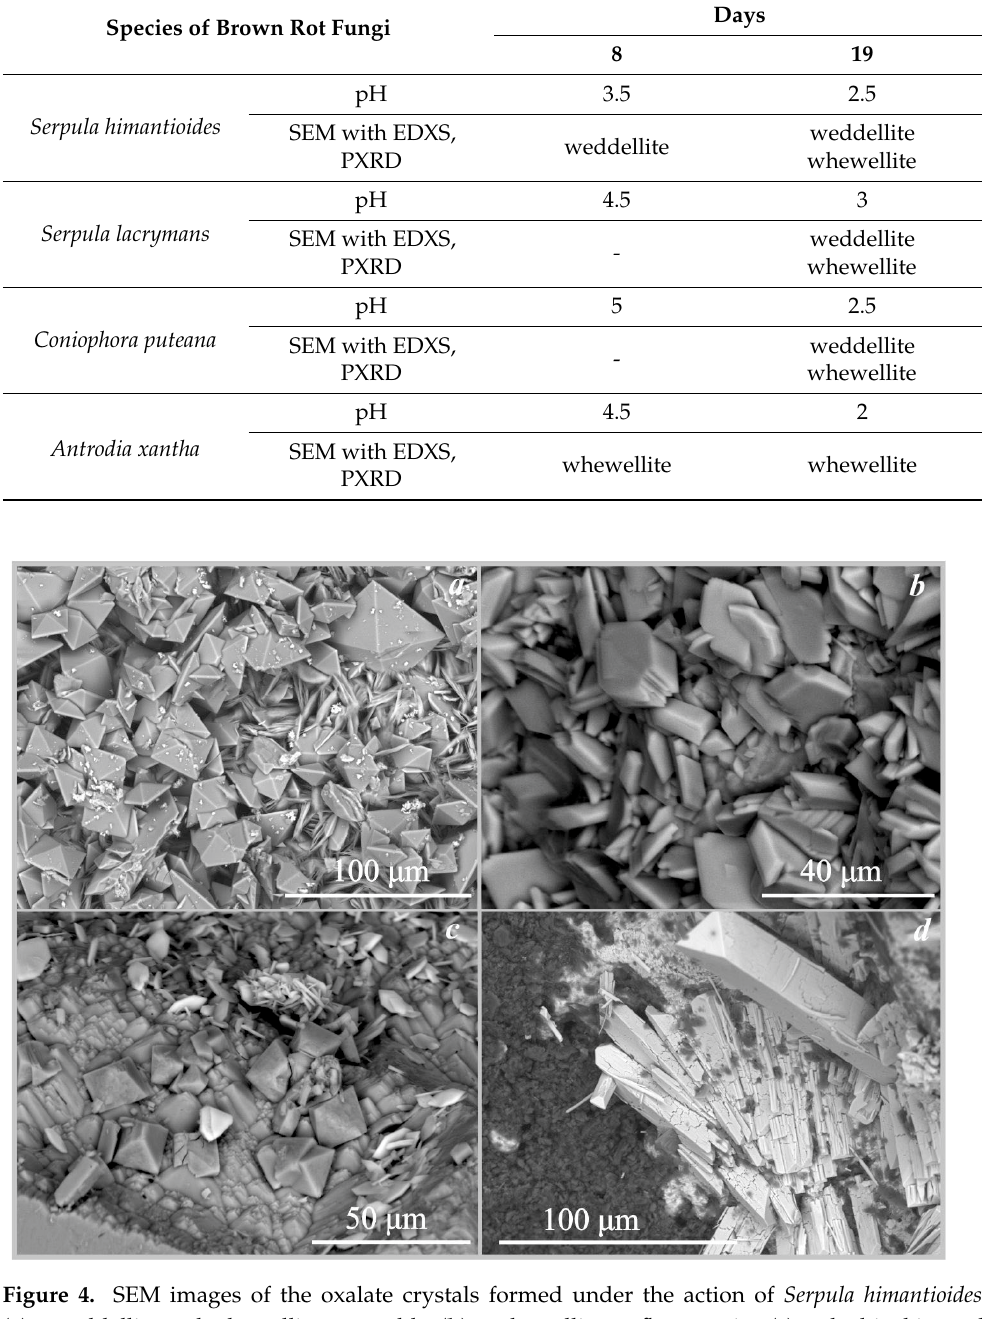
Figure 4. SEM images of the oxalate crystals formed under the action of Serpula himantioides : ( а )—weddellite and whewellite on marble; ( b )—whewellite on fluorapatite ; ( c )—glushinskite and ( a )—weddellite and whewellite on marble; ( b )—whewellite on fluorapatite; ( c )—glushinskite and whewellite on magnesite; ( d )—anhydrous lead oxalate on